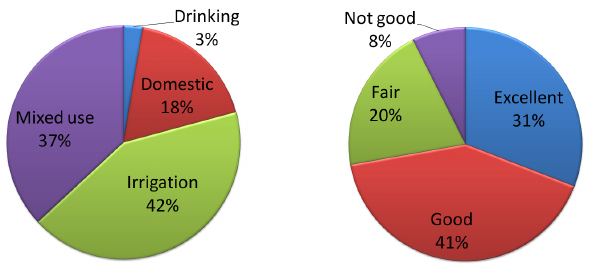
Fig. 7. Reported use and water quality of 149 active cisterns in